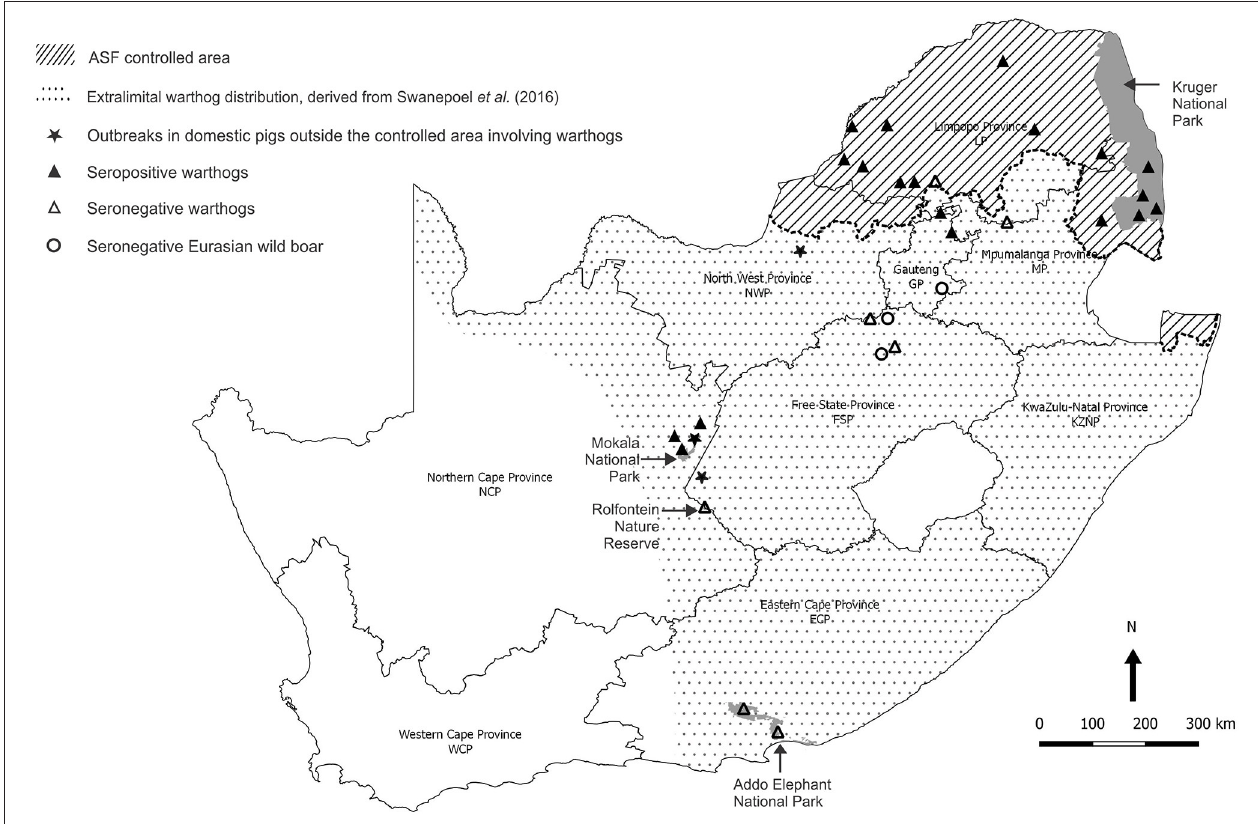
FIGURE 4 | Sites where samples from warthogs and Eurasian wild boars were obtained and tested for evidence of infection with African swine fever virus, and farms outside the controlled area where African swine fever outbreaks in domestic pigs were ascribed to contact with warthogs in 2017 and 2019.